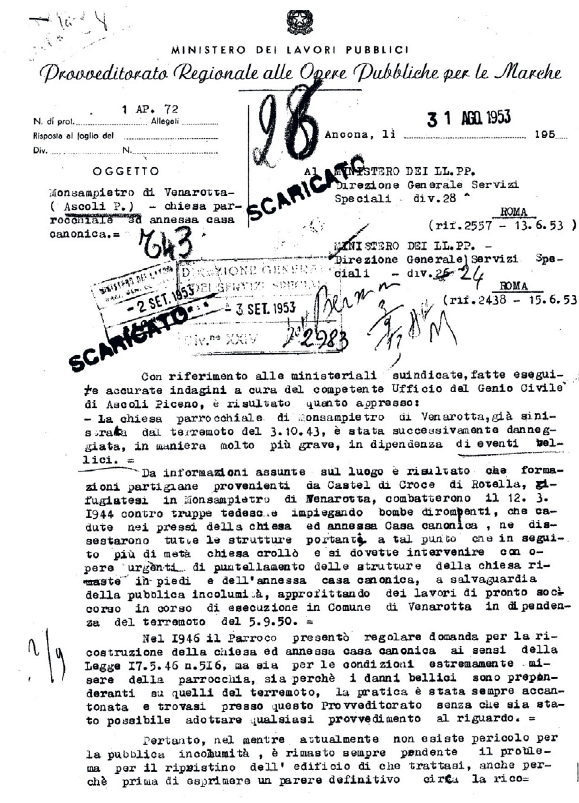
Figure 5. The damage history of the parish church of Monsampiero di Ve- narotta in a report sent by the Board for Public Works of the Regione Marche to the Ministry for Public Works on August 31, 1953 [AStRM, 1943-1972]. Translation: “After careful investigation by the Genio Civile of Ascoli Piceno, it re- sults as following: the parish church of Monsampietro di Venarotta, damaged by the earthquake of 3-10-1943, has later ravaged in a much more severe manner, by war ac- tivities. From local information we know that Partisans from Castel di Croce di Rotella, […] fighted on the 12-03 1944 against the German army using block-busters, which, falling near the church, compromised the structures to such an extent that half of the church collapsed […], we had to intervene with urgent supports […] taking advantage of the first aid activities after the 5-9-1950 earthquake. In 1946 the parish priest claimed for a reconstruction of the church […] but both for the poor condition of the building and for war damage prevailed on earthquake damage, the dossier has always been set aside